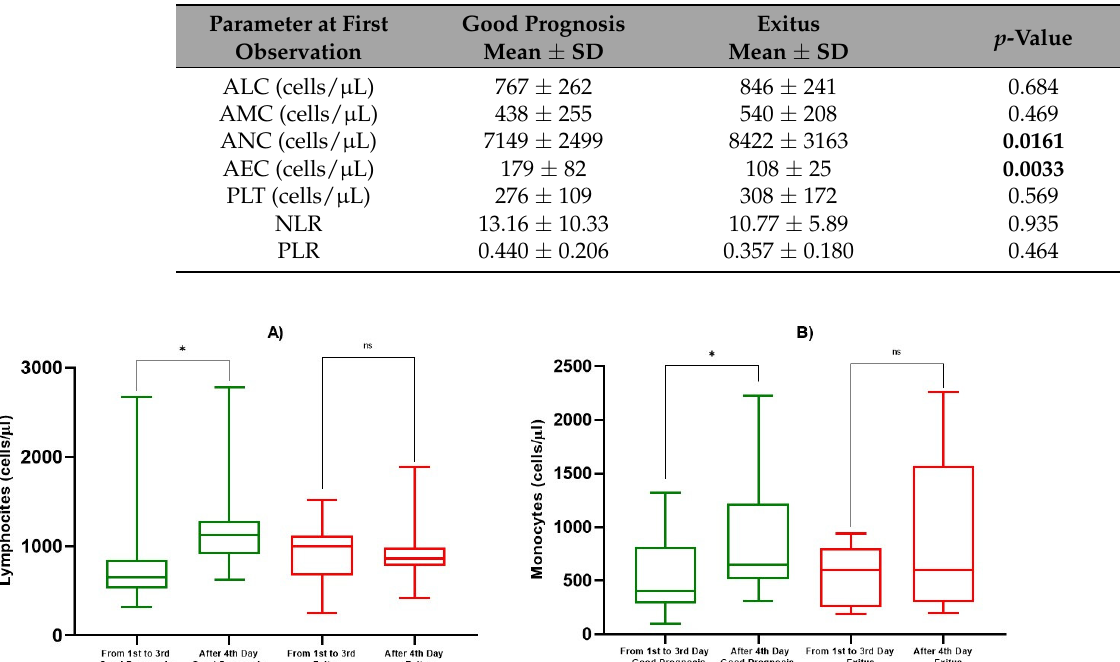
Figure 2. Box and whiskers for ALC and AMC. In ( A ), box and whiskers for ALC and in ( B ), for AMC among good prognosis and exitus patients for determinations between the first and third day and from the fourth day onward. The significant p -values are marked with * (from 0.01 to 0.05), not significant are marked with ns ( ≥ 0.05). Table 3. Analysis of ALC and AMC at different time points (days of hospitalization). Mean, deviation standard, and p-value at first observation, between the first and third observation, and from the fourth observation onwards among the Good Prognosis Group and the Exitus Group. The significant p -values are shown in